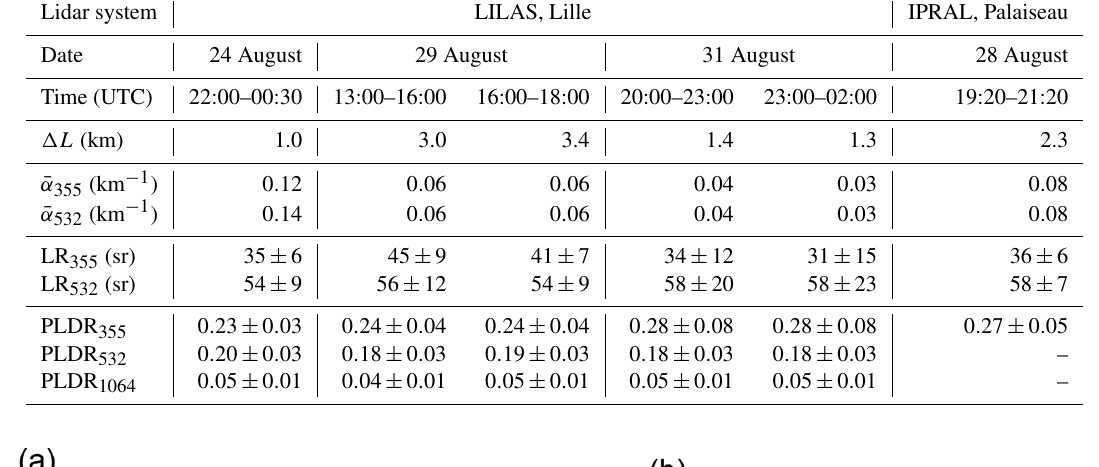
Table 2. Retrieved lidar ratios (LRs), particle linear depolarization ratios (PLDRs), layer thickness, and mean extinction coefficients from multi-wavelength lidar systems LILAS in Lille and IPRAL in Palaiseau. ¯ α is the mean extinction coefficient in the stratospheric smoke layer. (cid:49)L is the thickness of the stratospheric smoke layer. The values after “ ± ” represent the errors. Error estimation is presented in the Appendix. Lidar system LILAS, Lille